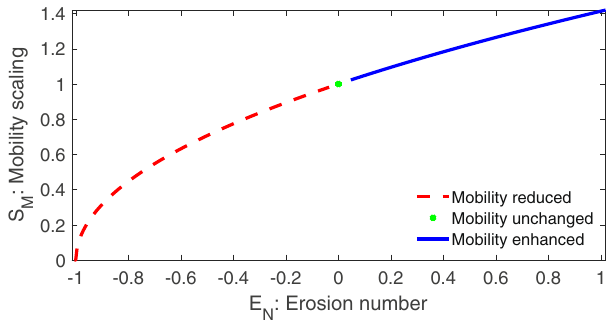
Fig. 4 Non-linear dependency of the mobility scaling S M on the erosion number E N given by (26) and (28). Three distinct mobility regimes